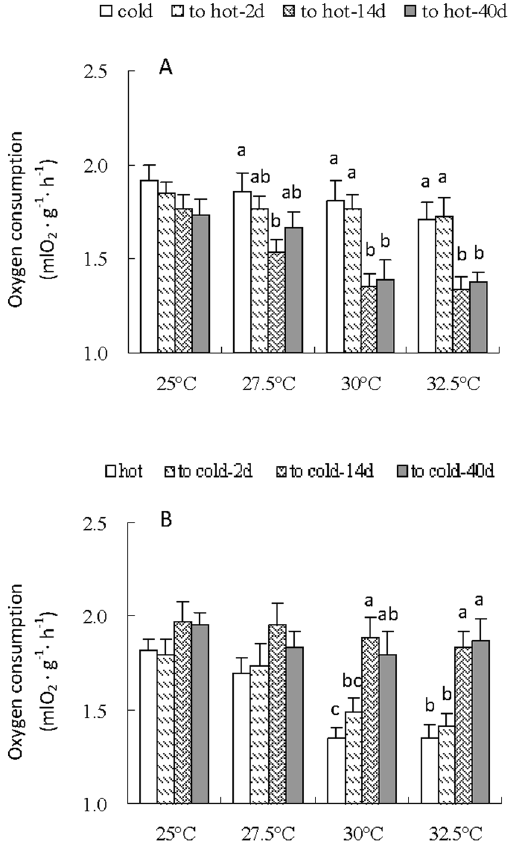
Figure 3. Oxygen consumption of striped hamsters during the transition of cold to hot (A) and hot to cold condition (B). Different letters (a, b or c) above the columns indicate significant difference between the four groups under same temperature ( P , 0.05). Data are means 6 s.e.m.